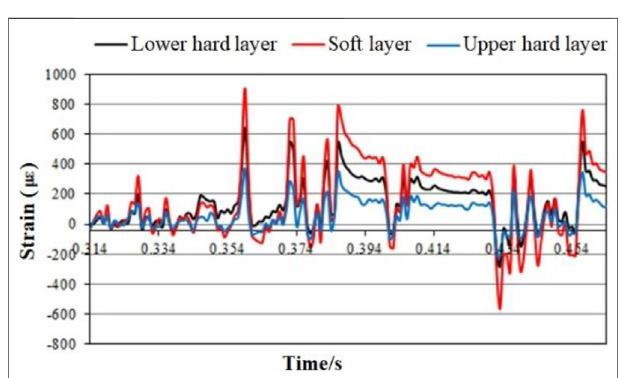
FIGURE 8 | Vertical strain characteristic curve Ⅰ during simultaneous blasting of Nos 1, 2, and 3.